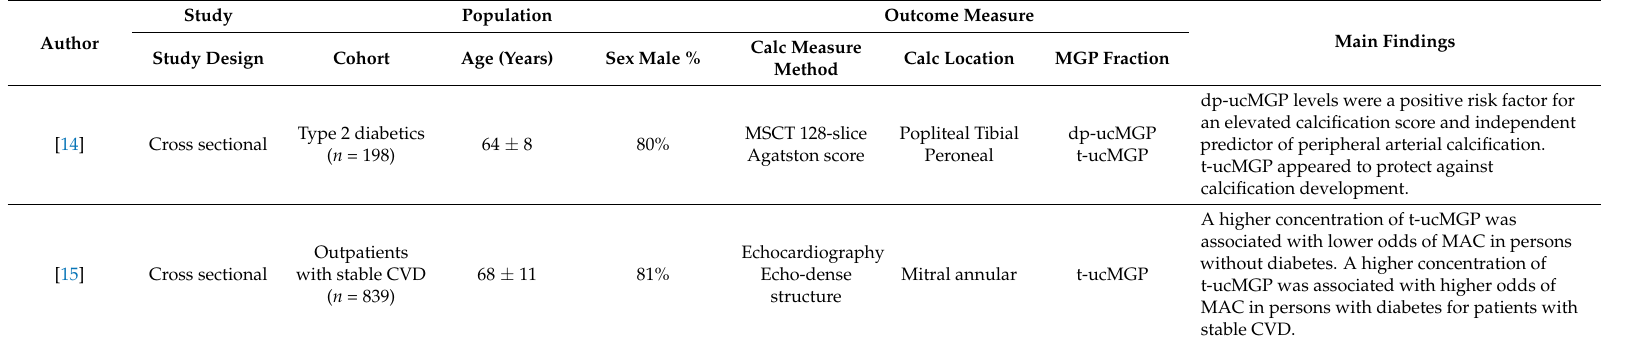
Table 5. Association between MGP fractions and vascular calcification in diabetic